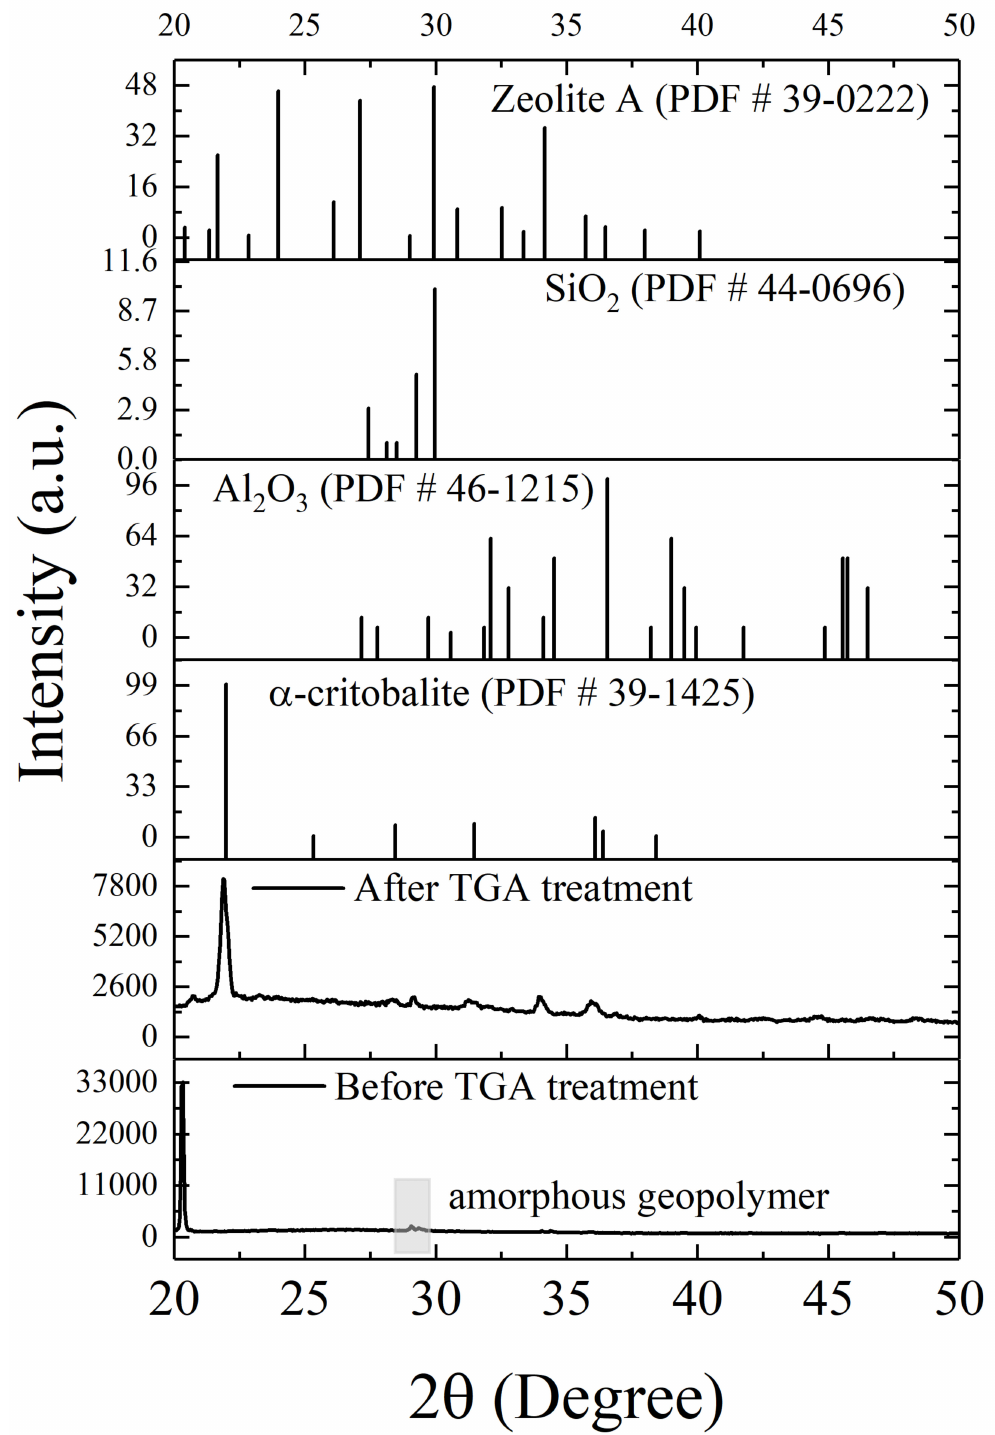
Figure 4. XRD patterns of intumescent flame-resistance coatings with 3 wt.% of ammonium polyphosphate and pentaery- thritol before and after thermal treatment in the TGA